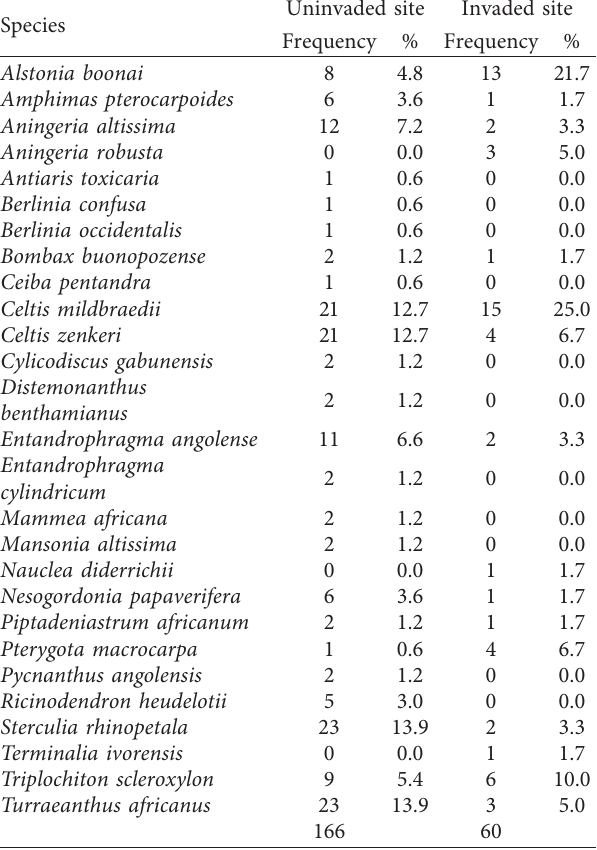
Table 5: Naturally regenerated economic tree species on study sites.